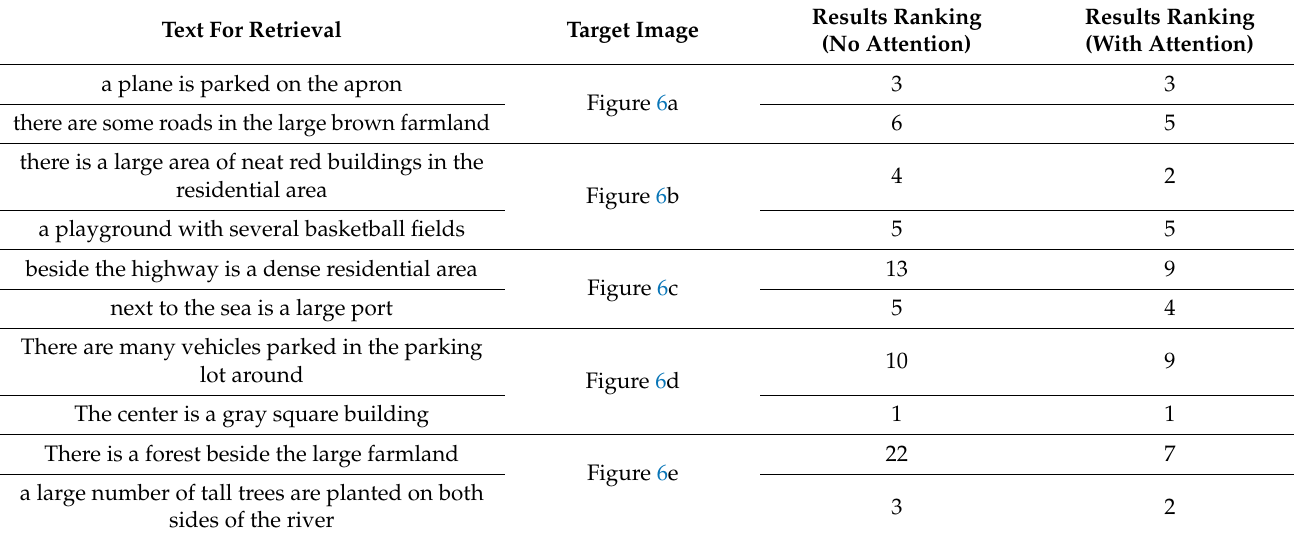
Table 5. Comparison of rankings between the statements for retrieval and the target images used in the